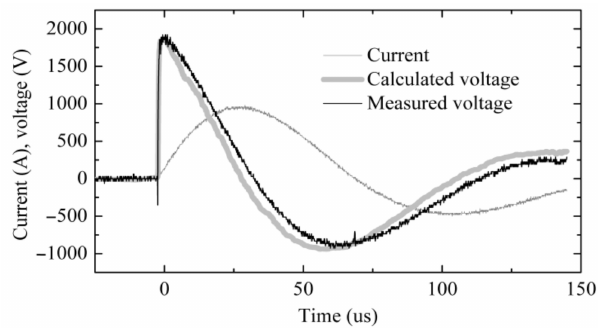
Figure 5. Waveforms of the current and the voltages in the